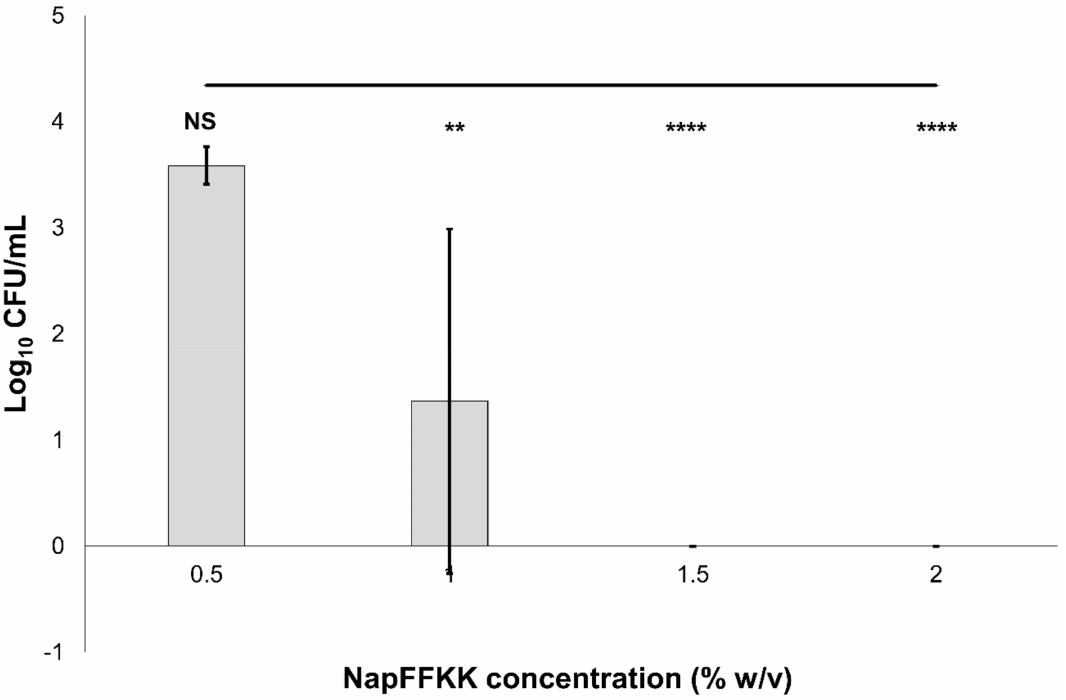
Figure 5. Fungal viability counts (Log 10 CFU/mL) of Candida parapsilosis ATCC 22019 after 24 h exposure to NapFFKK-OH. Black line represents negative growth control (fungi only). NS: no significant difference ( p ≥ 0.05), **: p < 0.01, ****: p < 0.0001 significant difference between Log 10 CFU/mL NapFFKK-OH treatment and the negative control.